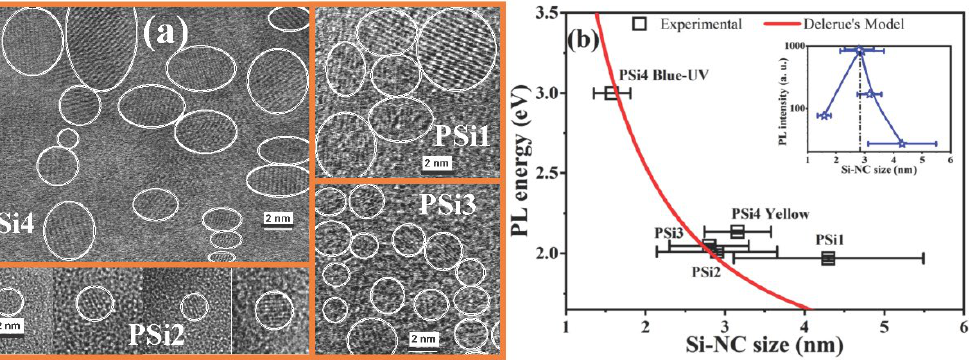
Figure 5. ( a ) HRTEM images of PS films and ( b ) PL energy as a function of the Si-NC. Inset in ( b ) shows the PL intensity for different Si-NC size.